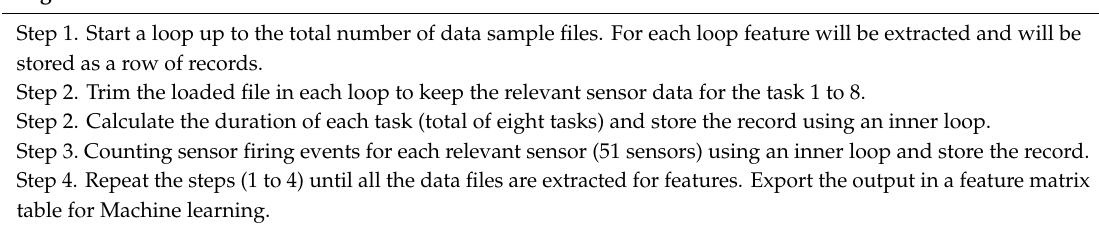
Algorithm 1 to extract features from the CASAS dataset: Algorithm 1 Procedure to extract features from the